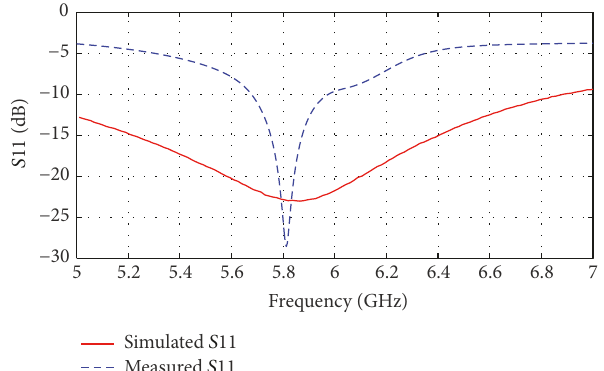
Figure 12: Simulated and measured 𝑆11 of the proposed antenna.